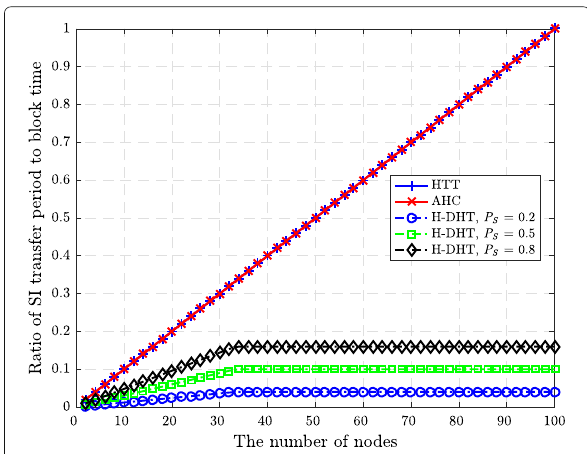
Fig. 5 Ratio of SI transfer period to block time according to the number of nodes. Figure 5 shows the effect of the number of nodes to the ratio of the SI transmission period to a block time in the HTT, the AHC, and the proposed H-DHT according to the average probability of generating SI message, Ps, respectively. In the proposed H-DHT protocol, the ratio of SI period to block time increases slightly